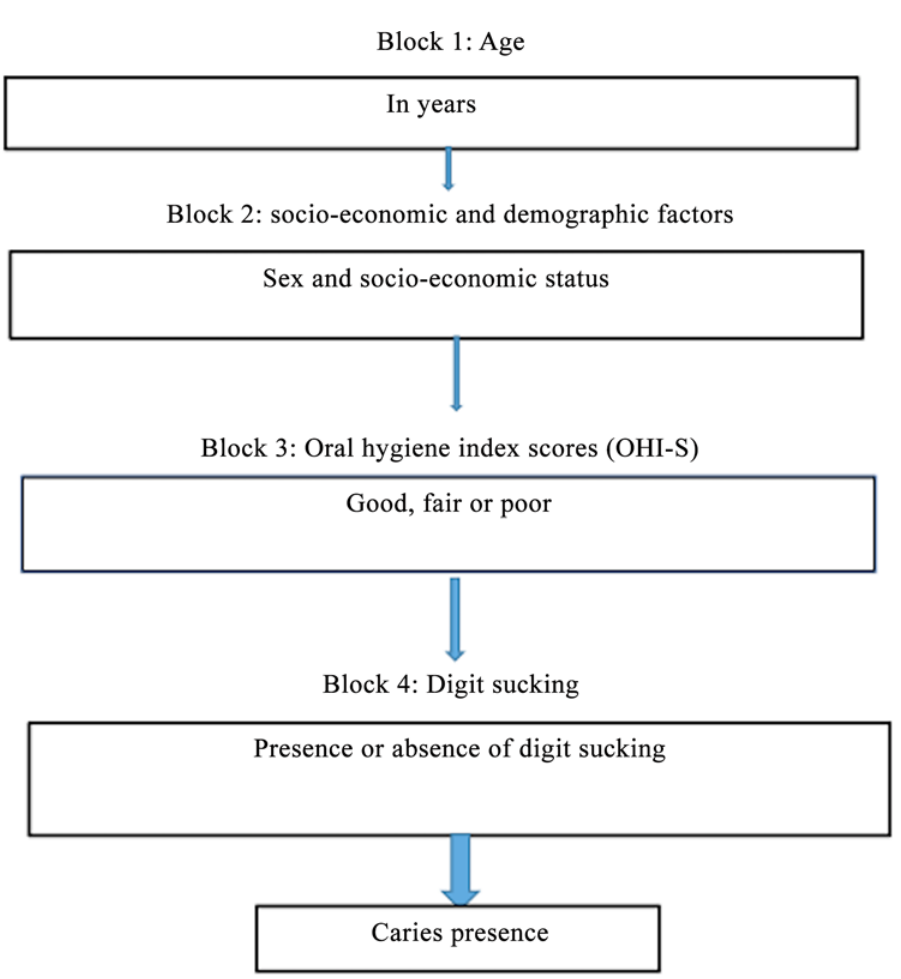
Fig 1. Hierarchical model for analysis of predictors of caries